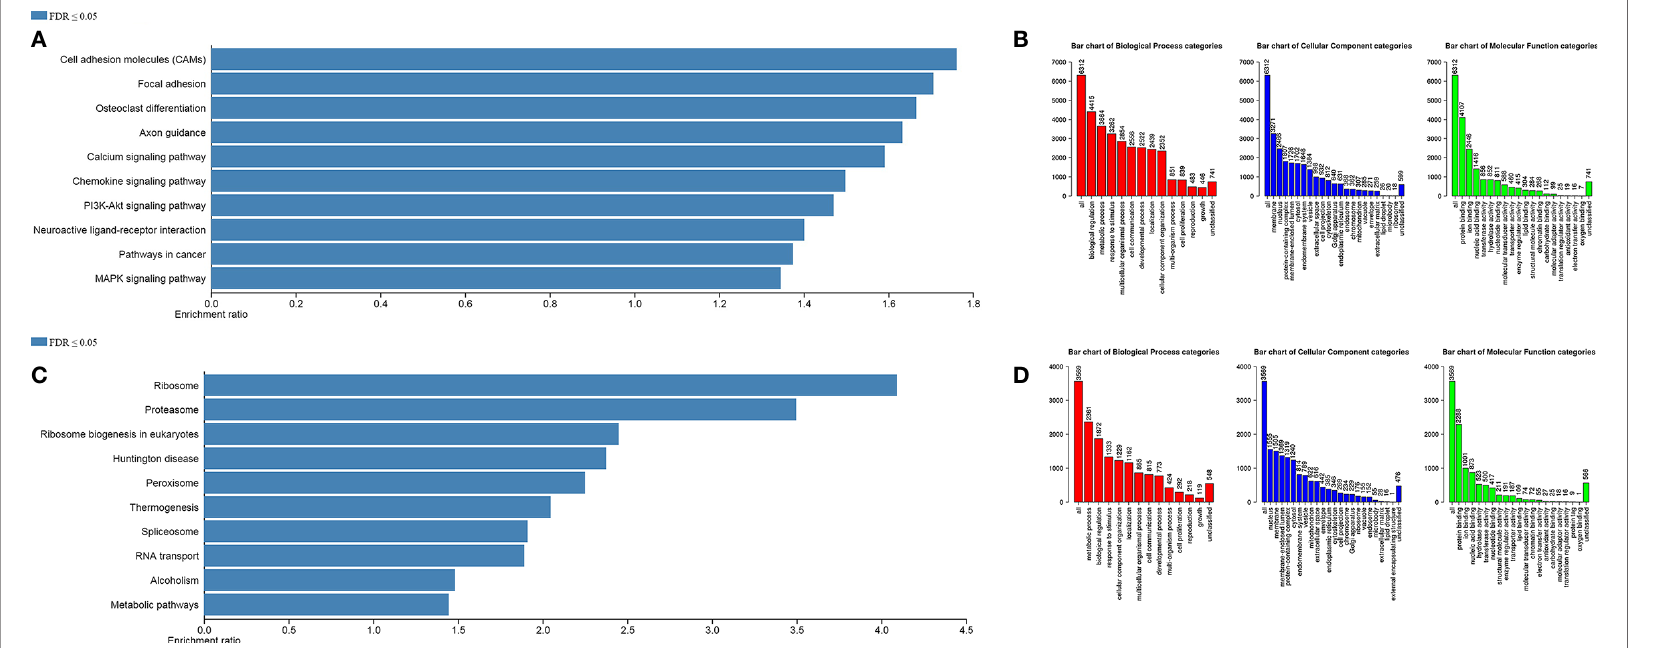
FIGURE 4 | Gene Set Enrichment Analysis. (A, B) KEGG pathways and Gene Ontology of signi fi cant positively correlated genes, respectively; (C, D) KEGG pathways and Gene Ontology of signi fi cant negatively correlated genes,